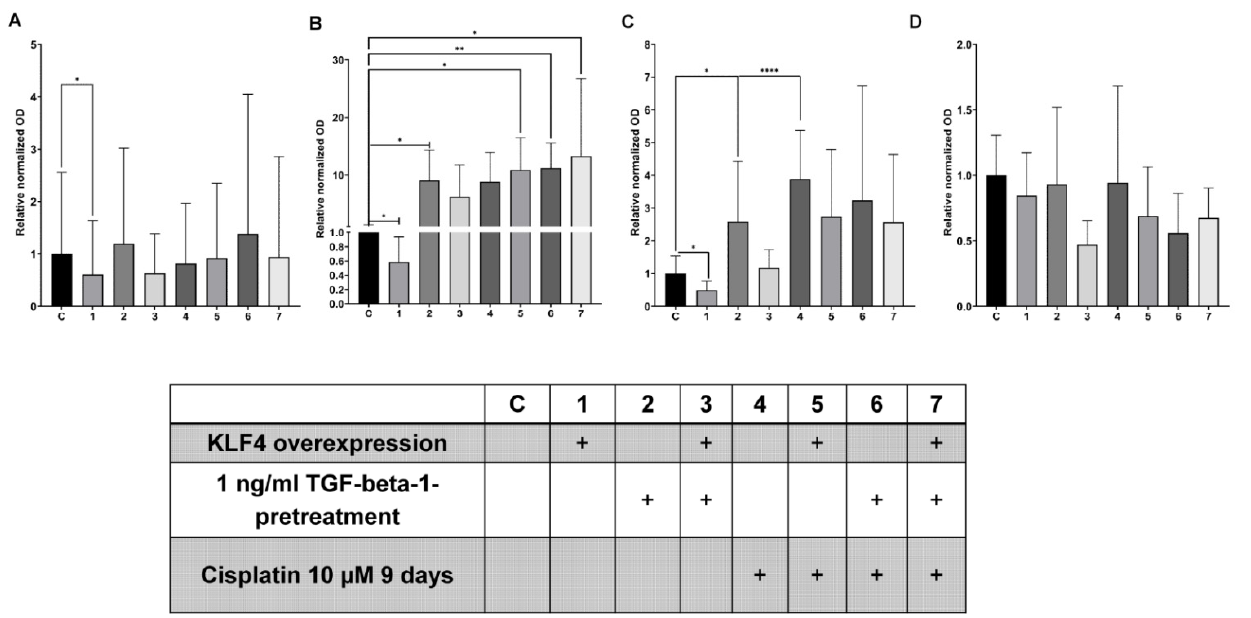
Figure 5. Quantification of the optical densities (ODs) of bands of six membranes for Slug ( A ), Vimentin ( B ), p-p38 ( C ) and E-cadherin ( D ). The optical densities were normalized with the corresponding GAPDH bands, and the mean value of the control (“C” in the explanatory table) was set to 1. The normalized OD of the treated samples was related to the mean value of the controls (from six repeats). The relative ODs for the treatments listed in segment lower panel (treatment table) are presented on the graphs ( A – D ). KLF4-overexpression resulted in 40–60% decrease of Slug, Vimentin, p-p38. Slug protein levels remained constitutive after TGF-beta1 and Cisplatin treatments. Both Vimentin and p-p38 levels increased substantially after TGF-beta1 and Cisplatin treatments. *: less than 0.05; **: less than 0.01; ****: less than